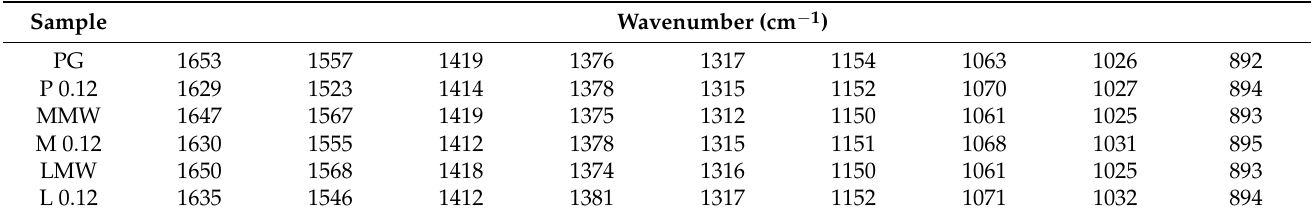
Table 2. The peaks of the characteristic FTIR bands from the fingerprint region of the chitosan samples and those with a gold concentration of 0.12 mM.